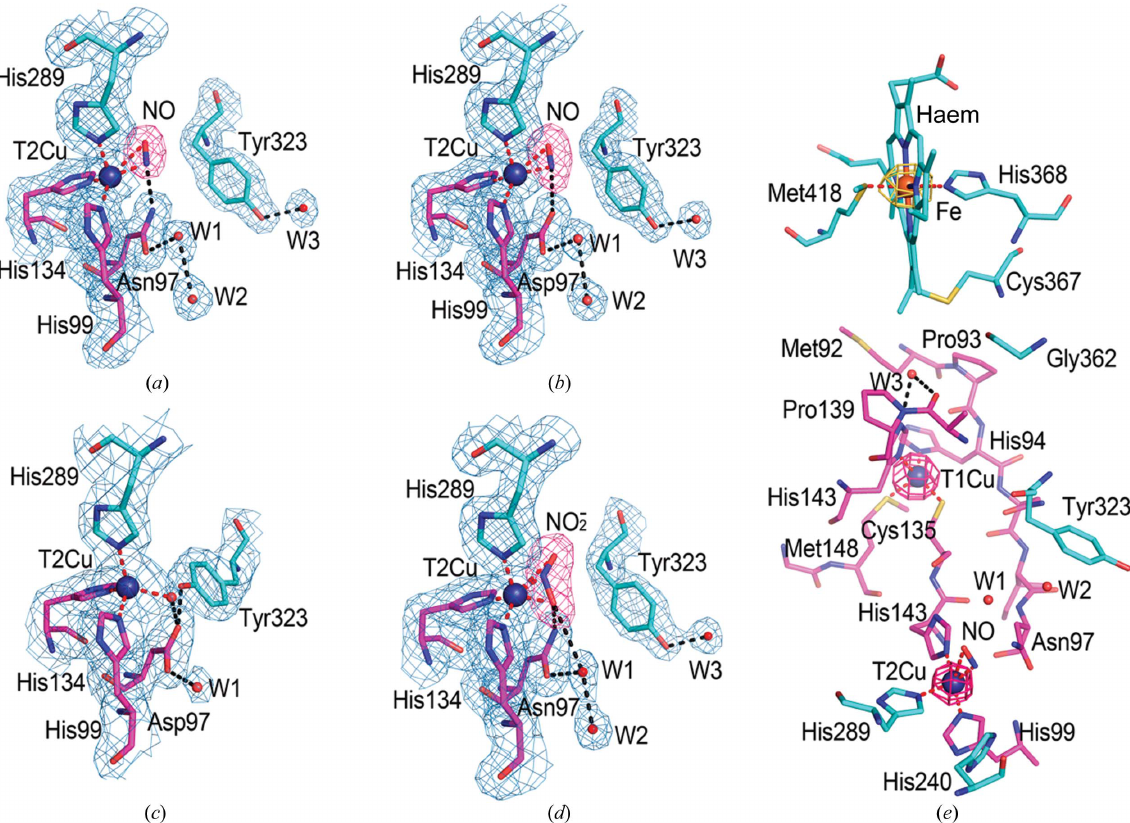
Figure 1 Details of the T2Cu sites of Rp NiR and its D97N mutant. ( a ) Rp NiR D97N–NO, ( b ) wt Rp NiR–NO and ( c ) wt Rp NiR without NO treatment in the same space group I 2 1 3. In both NO-bound structures Tyr323 is rotated away from the T2Cu site compared with the wild-type structure, where it hydrogen- bonds to an aspartic acid residue. W3 is not visible in the wild type here owing to limited resolution, but is well defined in high-resolution structures. ( d ) Rp NiR–NO 2 (cid:2) shows nitrite bound to T2Cu in an outward-facing manner. In ( a ) to ( d ) 2 F o (cid:2) F c electron-density maps are shown at 1.0 (cid:5) (blue mesh) and the F o (cid:2) F c OMIT maps of NO 2 (cid:2) and NO are at 7 (cid:5) (red mesh). His240 has been omitted for clarity. ( e ) An F o (cid:2) F c OMITanomalous map is shown at the 15 (cid:5) level around copper (1.33 A˚ X-ray wavelength; red mesh) and at the 20 (cid:5) level around iron (1.7 A˚ X-ray wavelength; orange mesh). Hydrogen bonds and copper-coordination bonds are shown as dashed black and red lines, respectively. The two adjacent monomers that form the catalytic centre are coloured magenta and cyan,